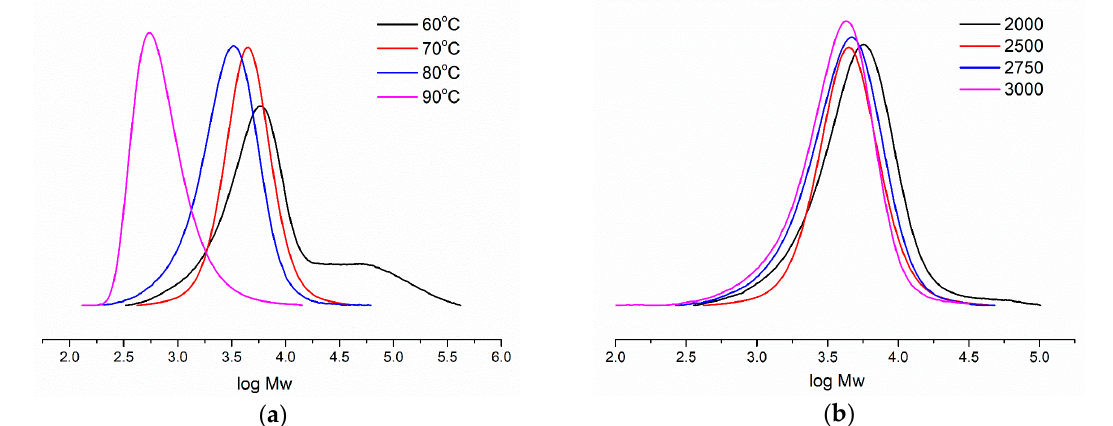
Figure 3. ( a ) GPC curves of the resultant polyethylenes by Fe2/MMAO various temperature (run 1–4, Table 3); ( b ) GPC curves of the resultant polyethylene by Fe2/MMAO various ratio of Al/Fe (run 2 and 5–7, Table 3).